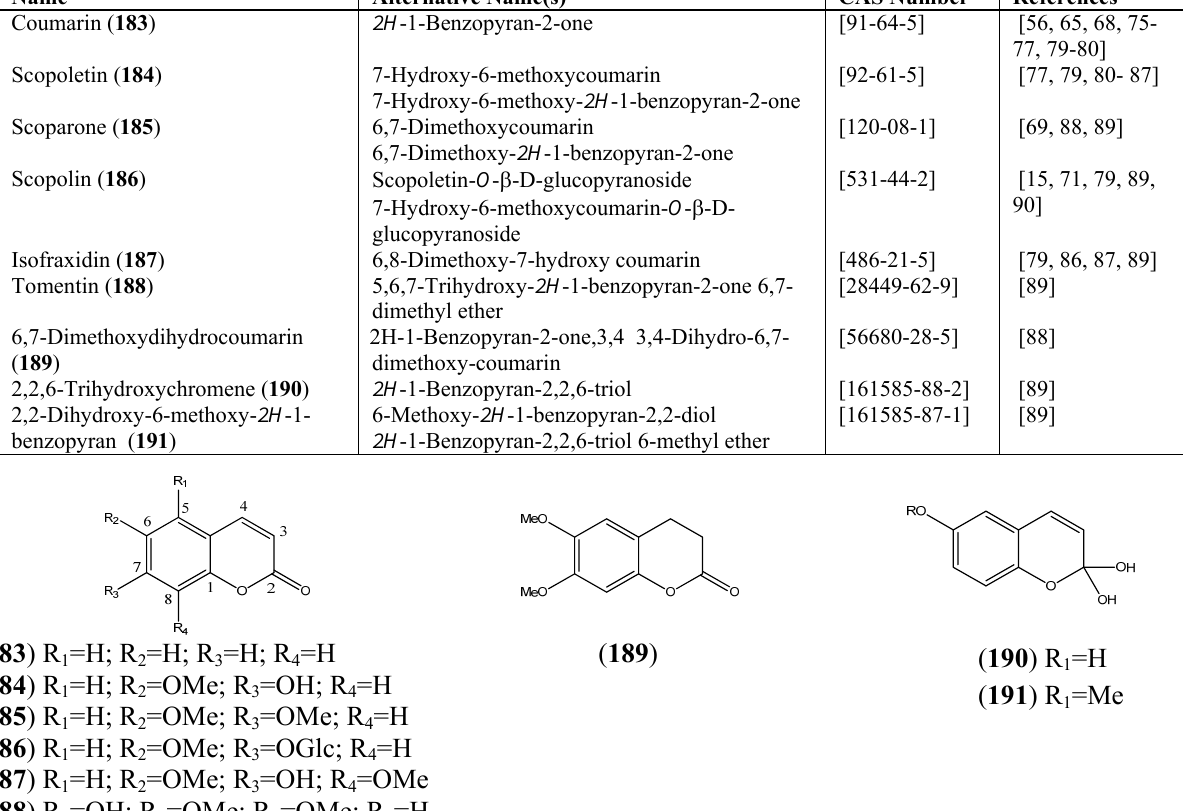
Table 17. Coumarins ( 2H -1-Benzopyran-2-one,